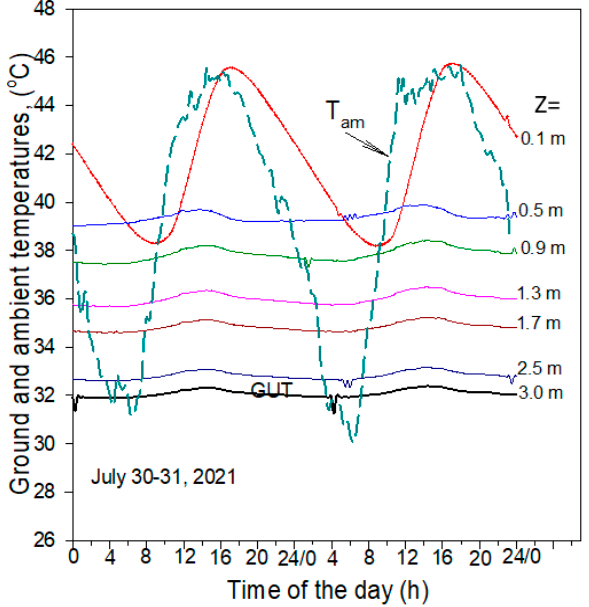
Figure 3. Diurnal variation in ambient temperature ( T am ) and underground soil temperature ( T g ) at different depths ( z ) in summer season (30–31 July 2021).